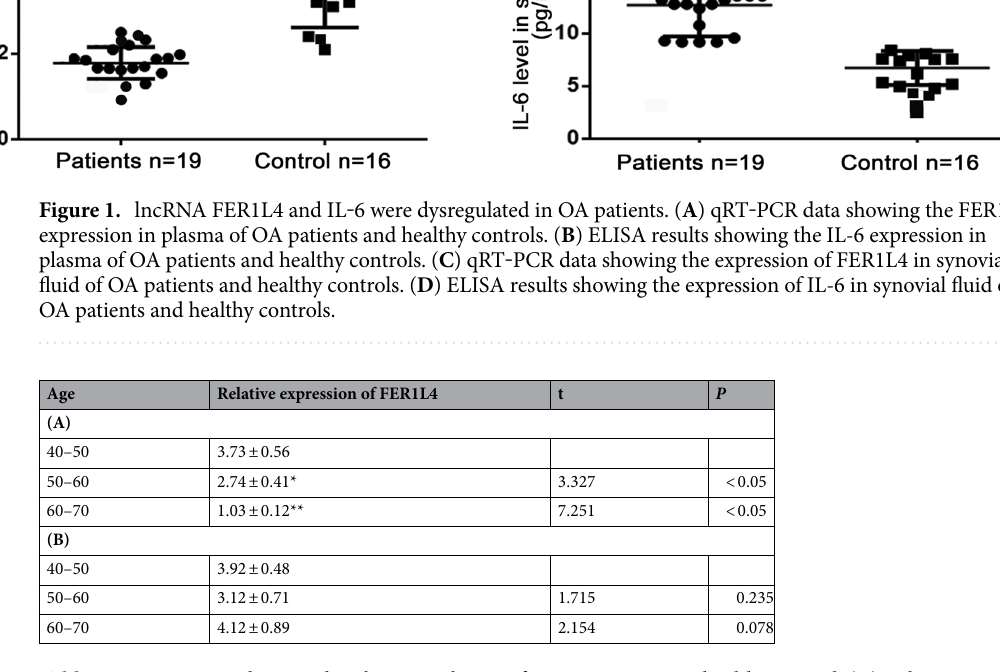
Table 1. FER1L4 was decreased with age in plasma of OA patients not in healthy control. (A) Relative expression of FER1L4 in different age groups of OA patients. (B) Relative expression of FER1L4 in different age groups of healthy controls. * P < 0.05; ** P < 0.01.